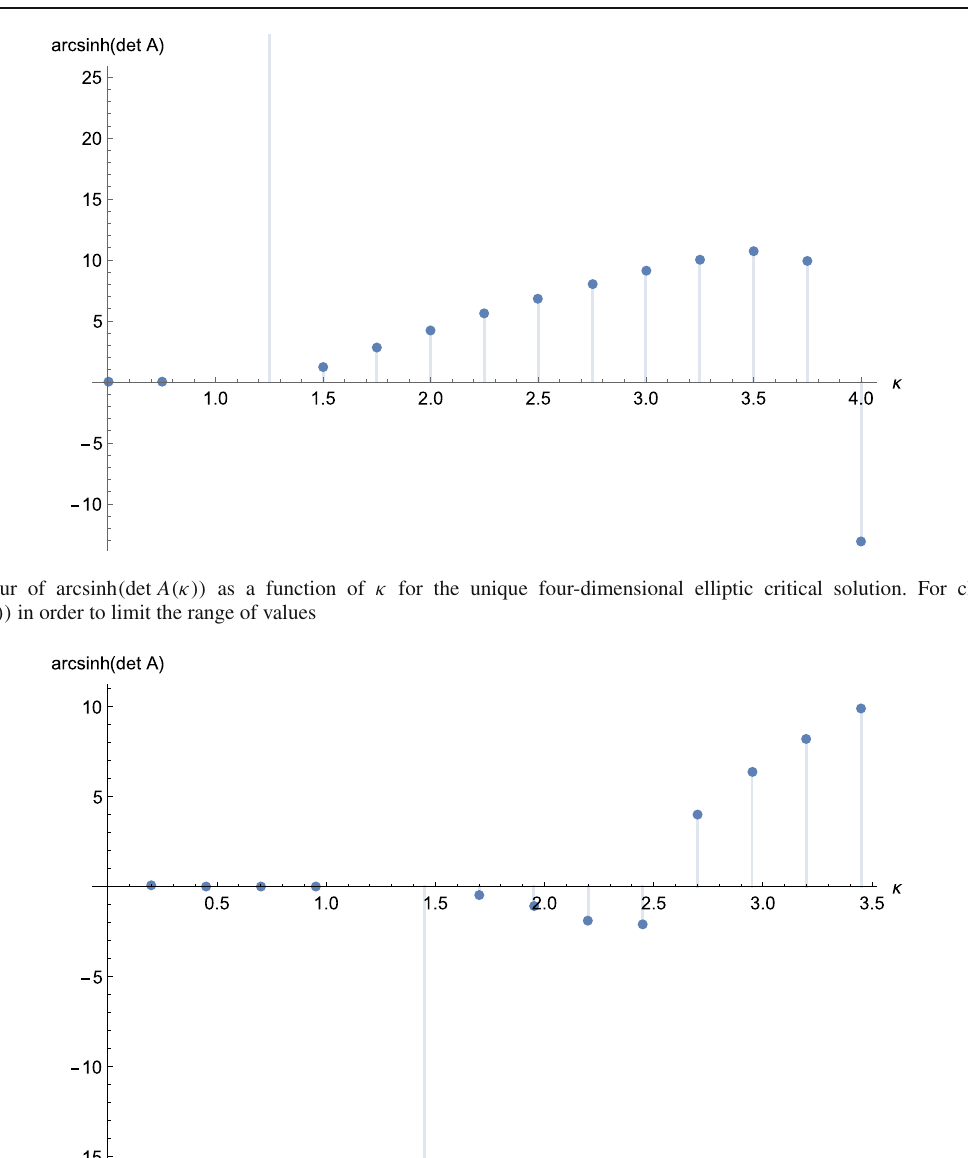
complex constraint is given by G ( h 0 ) = 0 at z + , and we ¯ G ( h 0 ) = 0 at z + . Hence we are left checked that it implies just with the complex-valued constraint H ( h 0 , h 1 | κ) = 0.